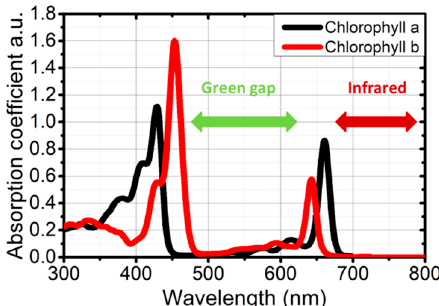
Figure 8. Absorption coefficient of chlorophyll a and b with the green gap and the infrared gap, modified from [49].